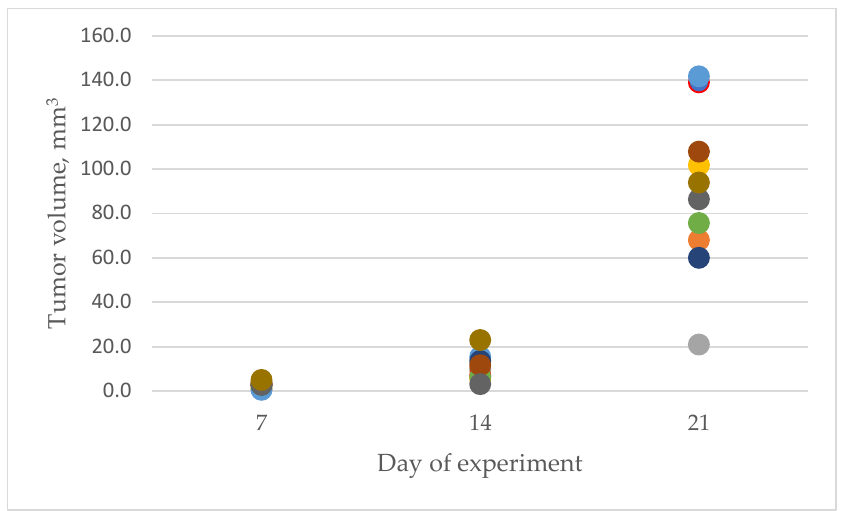
Figure 2. Tumor volume, measured on the 7th, 14th, and 21st day of the experiment.